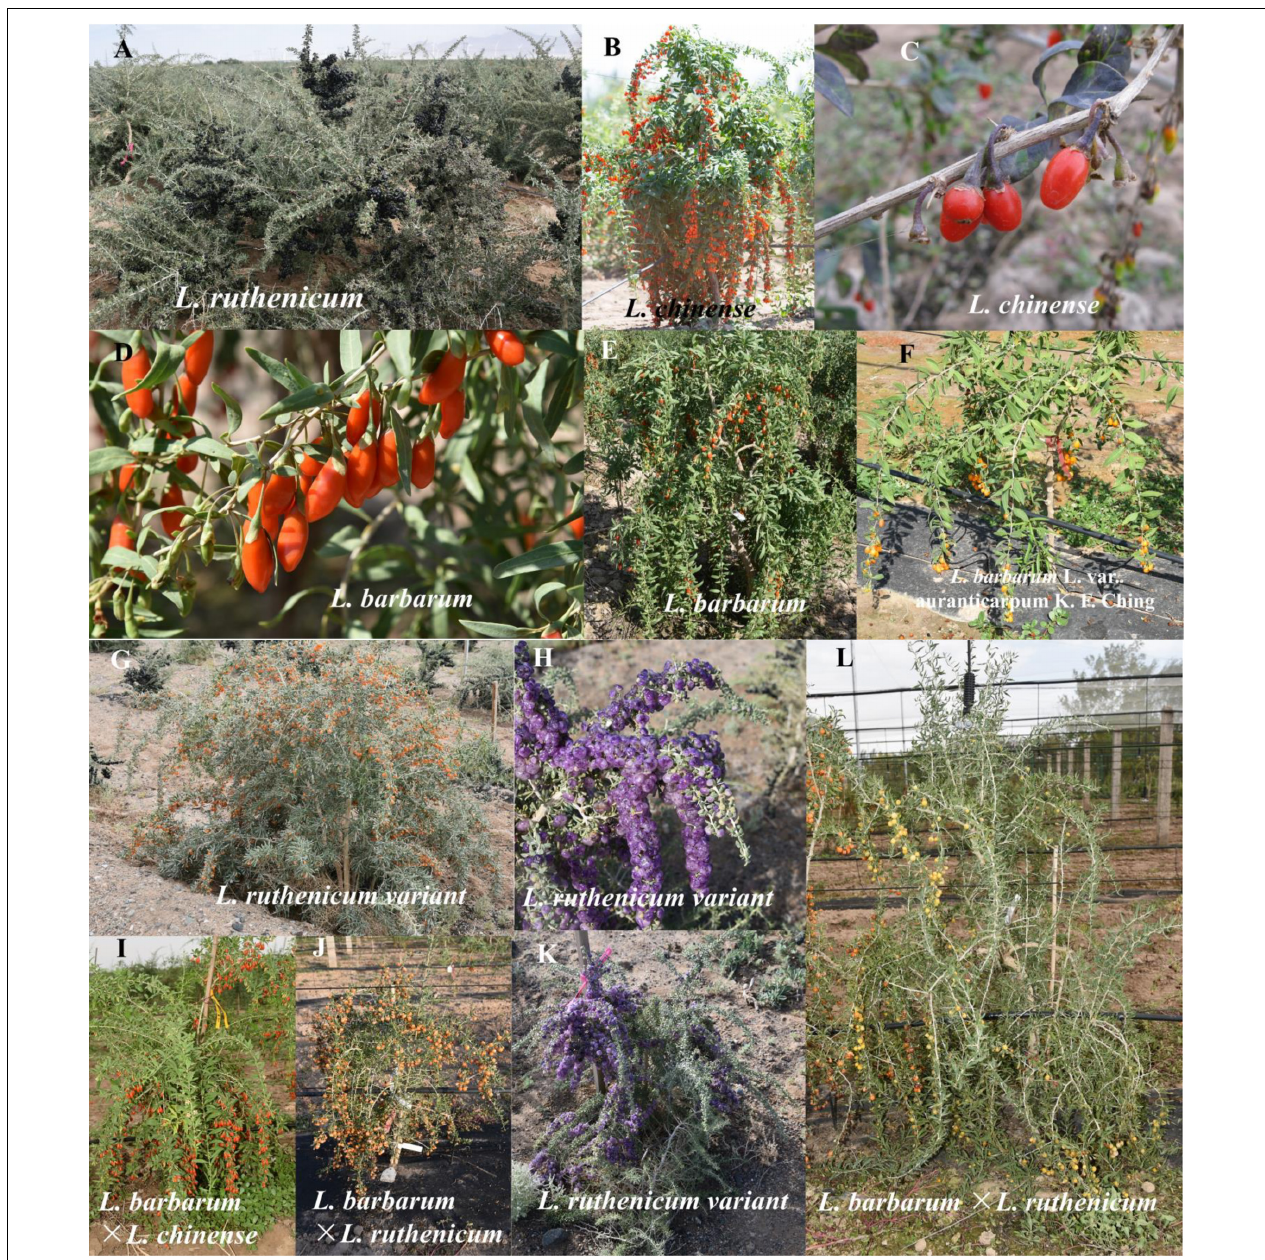
FIGURE 3 | Some collections of Lycium species in the resources. (A) L. ruthenicum ; (B,C) L. chinense ; (D,E) L. barbarum ; (F) L. barbarum variant; (G,H,K) L. ruthenicum variant; (I) offspring between L. barbarum and L. chinense ; and (J,L) offspring cross between L. barbarum and L. ruthenicum